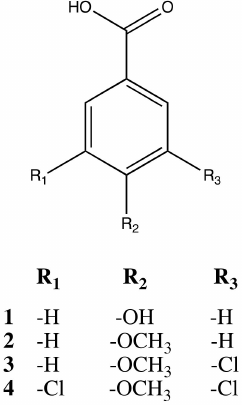
Figure 3. Chemical structures of the isolated compounds 1 - 4